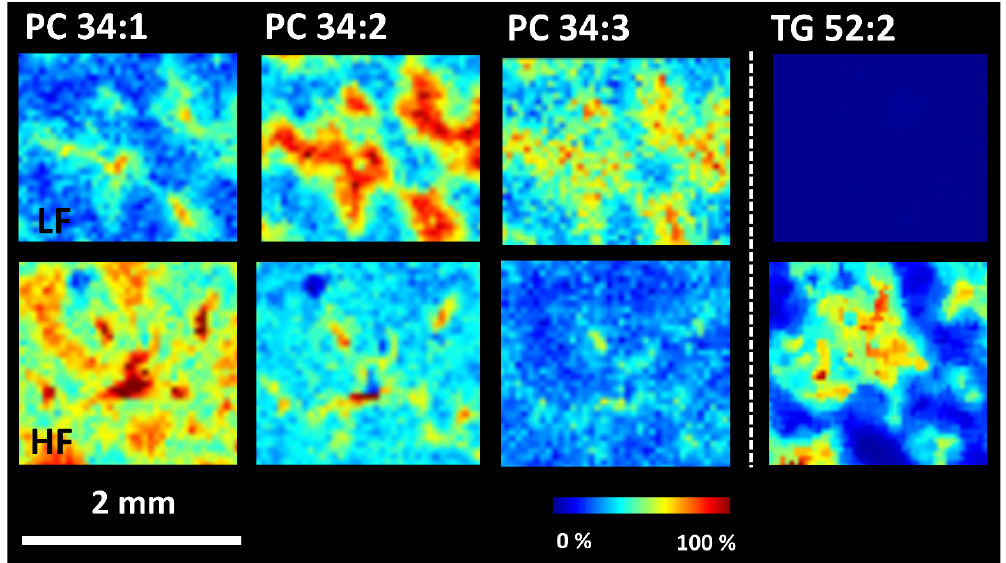
Figure 9. MALDI MSI analysis of WKY rats on LF and HF diet. Ion images of phophatidylcholines (PC 34:2, m / z 796.5; PC 34:1, m / z 798.5, [M + K] + ) and triacylglycerol (TG 52:2, m / z 897.7, [M + Na] + ) were obtained in positive ion mode at spatial resolution 40 μ m.